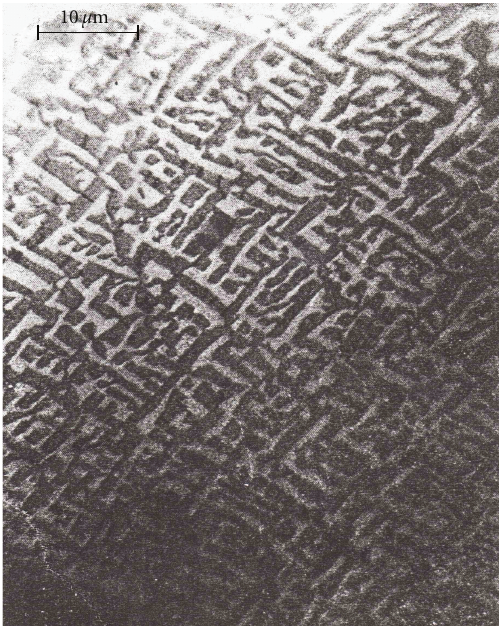
Figure 1: Microstructure of 1st ME composite by Suchtelen. Samples were fabricated by unidirectional solidification of a eutectic composition of the quinary system Fe–Co–Ti–Ba–O,